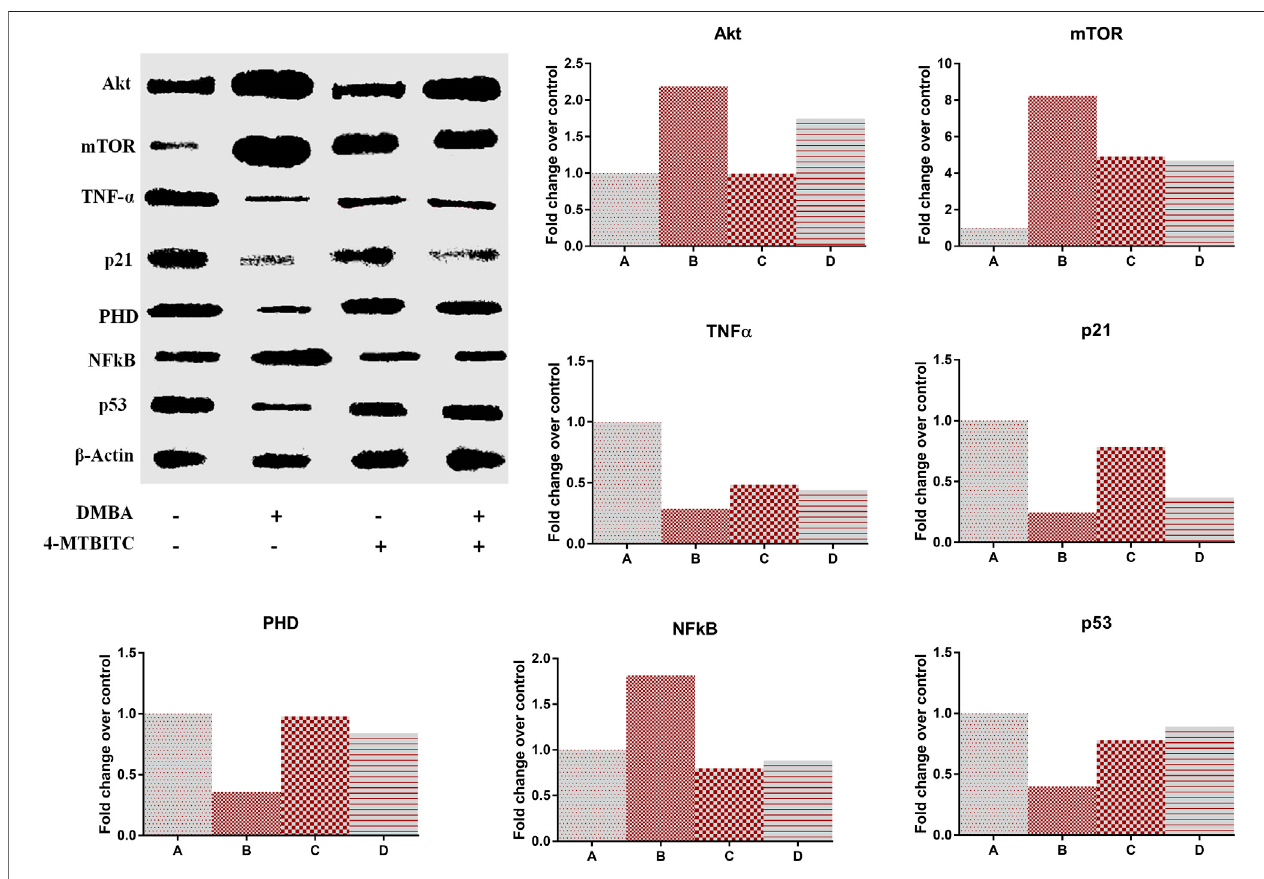
FIGURE 6 | Western blot analysis of different protein markers in response to the treatment of 4-(methylthio)butyl isothiocyanate and DMBA. (A) Representative expression of protein markers, (B) Akt, (C) Mammalian target of rapamycin, (D) Tumor necrosis factor- α , (E) p21, F Prolyl hydroxylase, (G) Nuclear factor-kB, (H) p53.